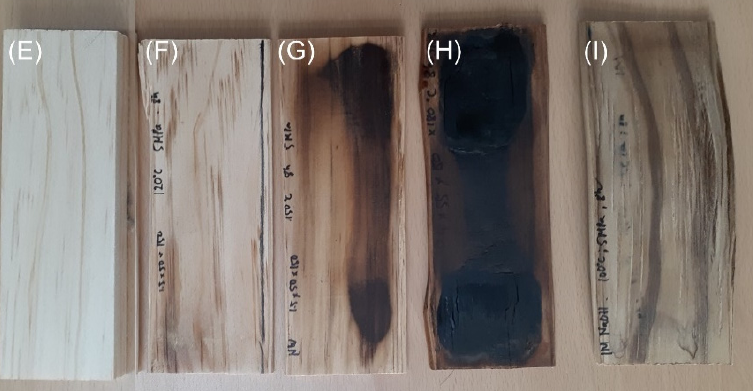
Figure 3. Cross-sectional FESEM images of compressed wood specimens ( A – D ): ( A ) B1, ( B ) B3, ( C ) B4, and ( D ) B5; Photographs of wood specimens ( E – I ): ( E ) natural wood, ( F – H ) compressed natural wood at 120 °C, 150 °C, and 180 °C under 5 MPa, ( G ) compressed B3 at 100 °C and 5 MPa.